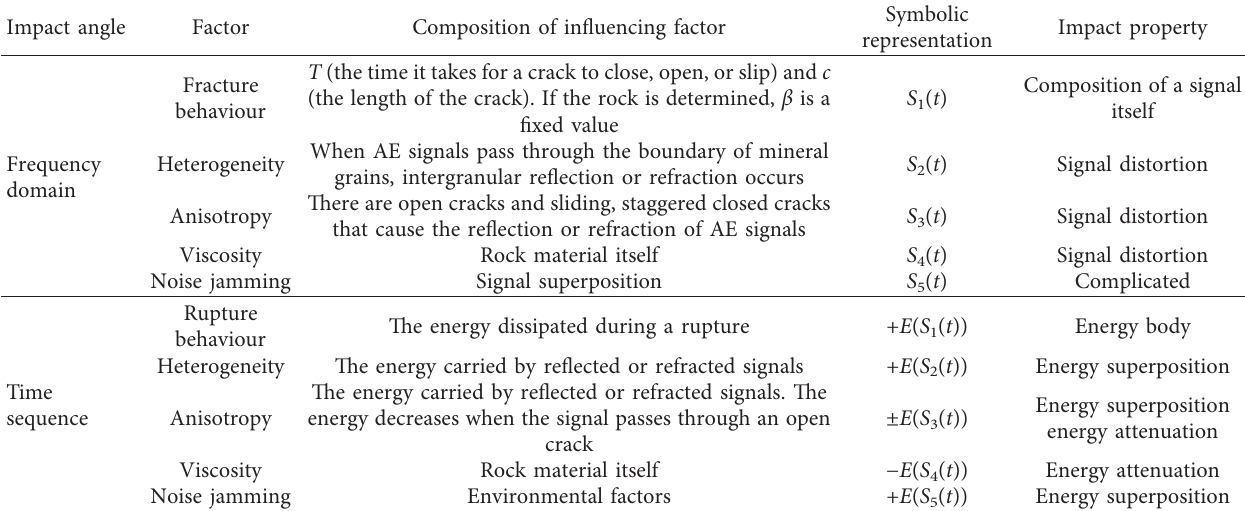
Table 2: Influential factors for and properties of AE signals during rock